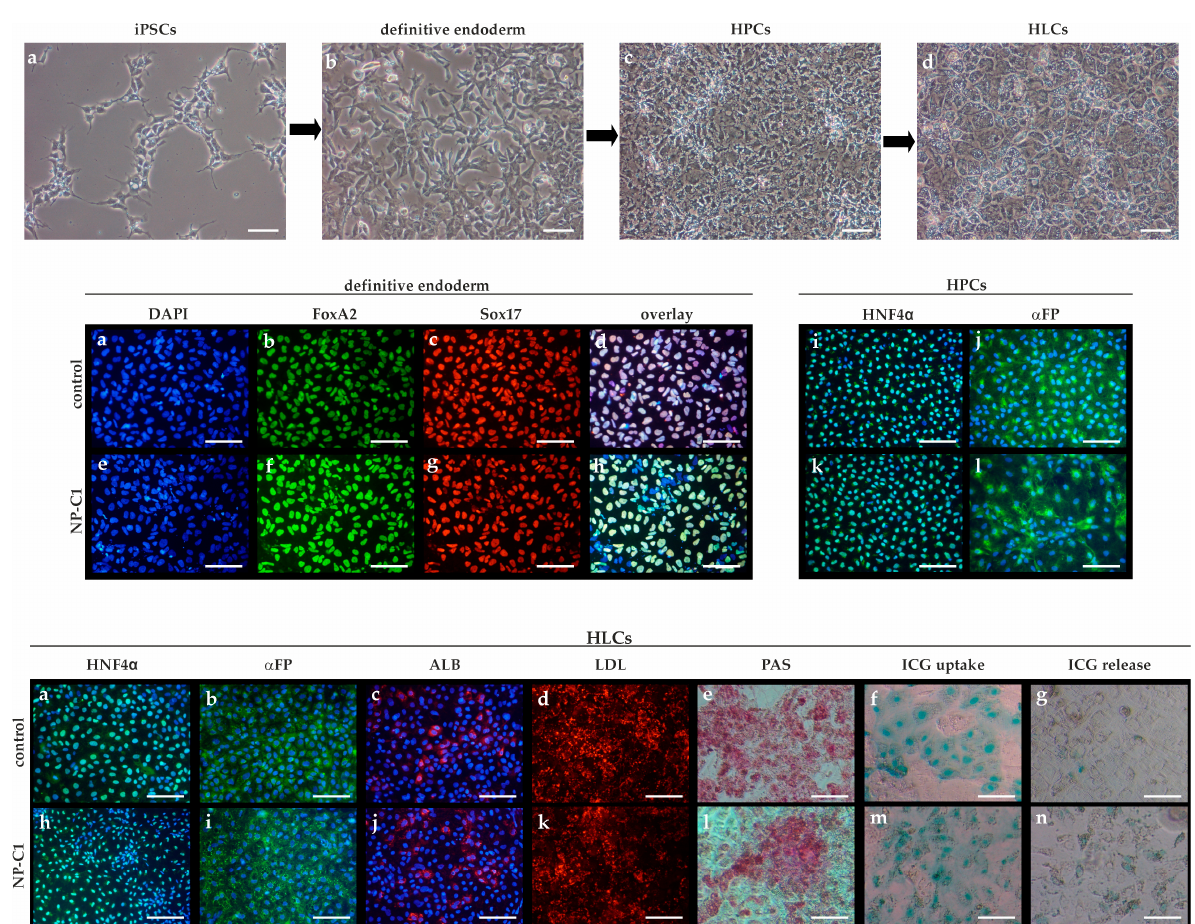
Figure 2. Hepatic differentiation from hiPSCs. Upper panel : Schematic representation of the hepatic differentiation protocol. ( a ) iPSCs, ( b ) definitive endoderm cells, ( c ) hepatic progenitor cells (HPCs), ( d ) hepatocyte-like cells (HLCs). Middle panel : ( a , e ) DAPI staining for visualization of nuclei. ( b , f ) Staining of FoxA2 (green) and ( c , g ) Sox17 (red), ( d , h ) overlay of a – c , and e – g , respectively. ( i , k ) Staining of HNF4 α (green, DAPI in blue), ( j , l ) staining of alpha-fetoprotein ( α FP, green, DAPI in blue). Lower panel : Hepatocyte-like cells (HLCs) expressed lineage-specific markers such as HNF4 α ( a , h , green, DAPI in blue), α -fetoprotein ( α FP, b , i , green, DAPI in blue), and human albumin (ALB, c , j , red, DAPI in blue). HLCs displayed functional characteristics, such as the ability to uptake DiI-Ac-LDL ( d , k , red), glycogen synthesis, and storage as shown by PAS staining ( e , l ) and uptake ( f , m ) and release ( g , o ) of indocyanine green (ICG). Scale bar = 100 µm.